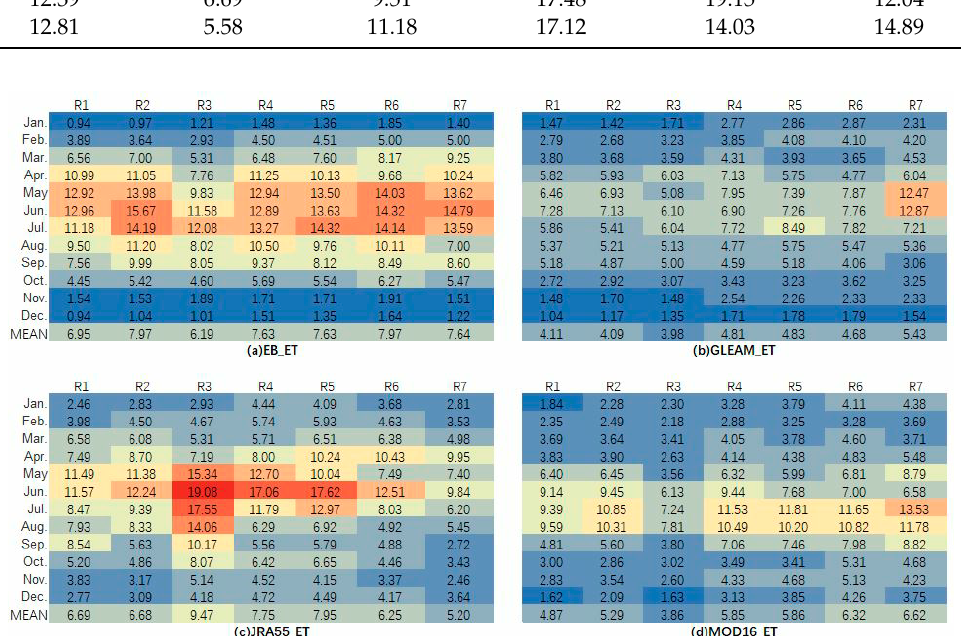
Figure 11. TCH comparison results for each sub-basin in the different months. Blue represents low uncertainty, red represents high uncertainty. The color from blue to red represents the value of un- certainty from low to high. R1—Luan River Basin; R2—Chaobai River and Jiyun River Basin; R3— Inland River Basin; R4—Daqing River Basin; R5—Ziya River Basin; R6—South Canal Basin; R7— Tuhai River and Majia River Basin. In terms of the sub-basins, there was not much difference between the different sub- basins. Except for the JRA_ET data, the highest or second-highest values of the other prod- ucts all occurred in the Tuhai River and Majia River Basin (R7). 4. Discussion 4.1. Spatial Distribution of ET under Different Land-Cover Types The spatial distributions of the mean annual ET from 2003 to 2012 are shown in Fig- ure 12. The ranges of different ET products vary greatly. Generally, the coarser the spatial resolution of the ET products, the smaller the range of the ET values. According to the spatial distribution of ET, the evapotranspiration in the northwest of the Haihe River Ba- sin is lower than that in the southeast.